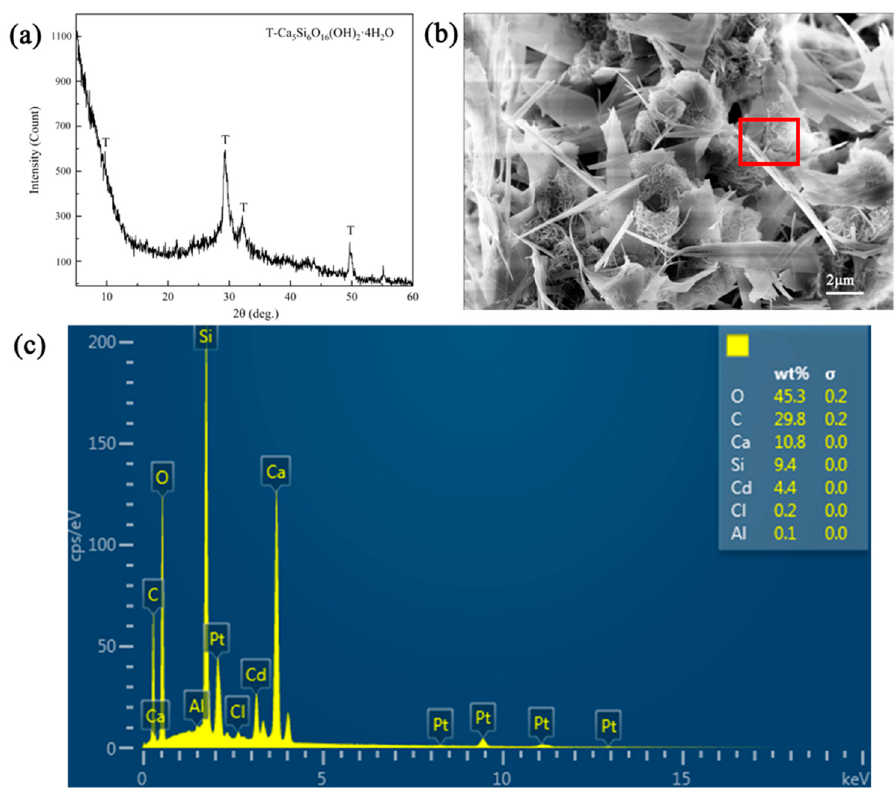
Figure 8. ( a ) XRD pattern, ( b ) SEM and ( c ) EDS (the detection area was in the red box of ( b )) images of tobermorite after Cd 2+ adsorption.